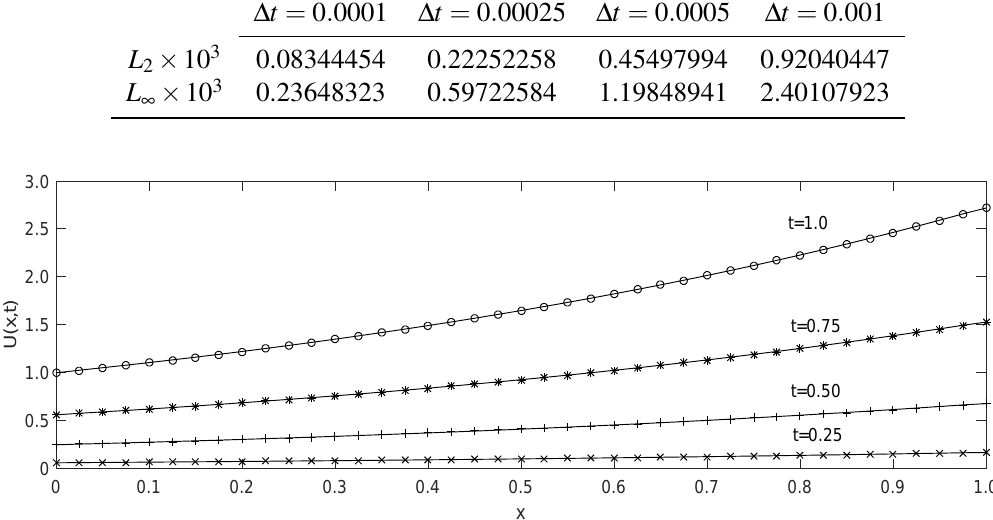
Fig. 3 A comparison of the analytic and approximate solutions using the Crank-Nicolson method for ν = 1 . 0, N = 40, γ = 0 . 5 and ∆ t = 0 . 0025 at different values of final